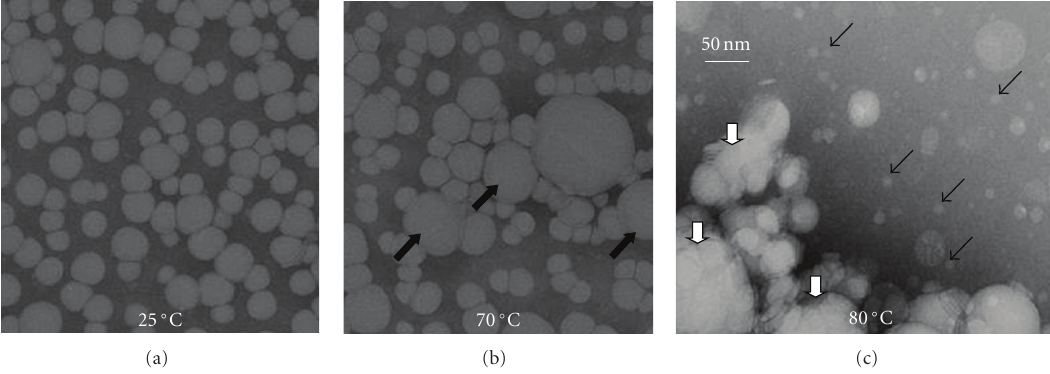
Figure 3: Negative stain electron microscopy of intact and heated human plasma VLDL. Bu ff er conditions are 10mM Na phosphate, pH 6.2. Lipoproteins were intact (a) or heated at a constant rate of 11 ◦ C/h to 70 ◦ C (b) or 80 ◦ C (c). Large black arrows indicate fused VLDL, large white arrows indicate lipid droplets formed upon VLDL rupture (such rupture is accompanied by loss of lipoprotein morphology and repacking of apolar core lipids indicated by near-UV CD), and small arrows point to small HDL-size particles whose detailed biophysical and biochemical analysis was reported earlier [20].